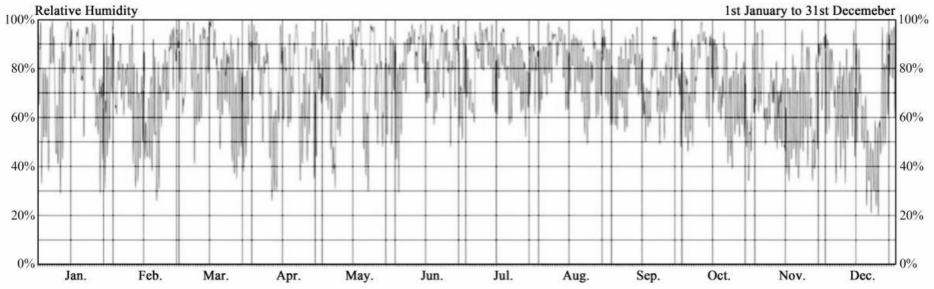
Figure 3. Daily relative humidity in the city of Hangzhou